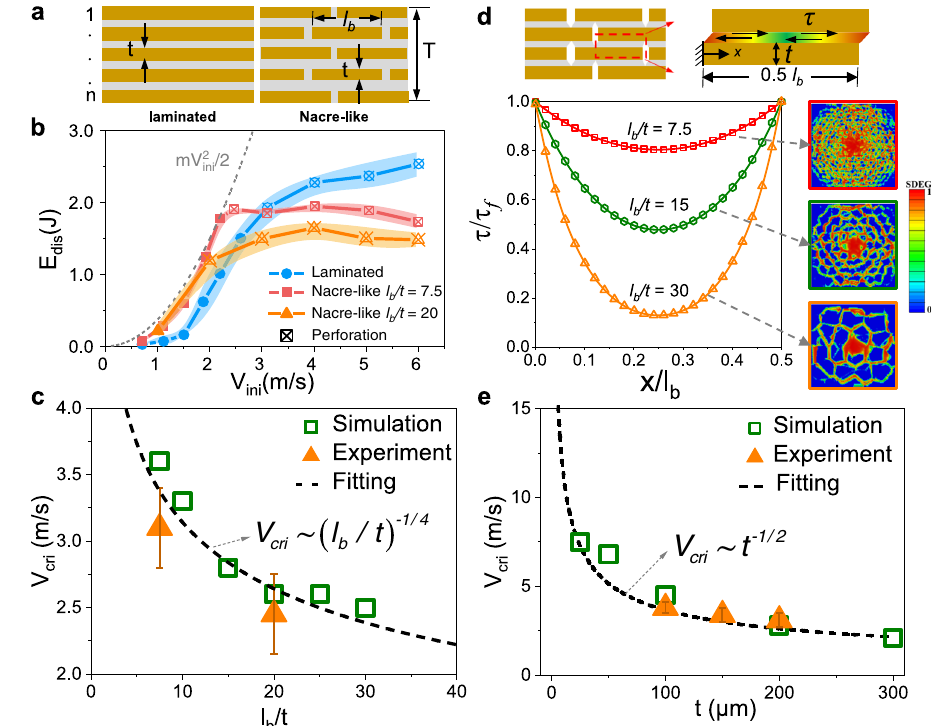
Fig. 5 | Effects of the structural geometry on the critical impact velocity. a Schematic of key geometry parameters in laminated and nacre-like structures. b Experimental E dis - V ini curves for the laminated structures and the nacre-like structureswithdifferenttabletaspectratios l b /t . c Thecriticalimpactvelocity V cri as functionof l b /t . d Analysisforshearstressdistribution τ inthenacre-likestructures